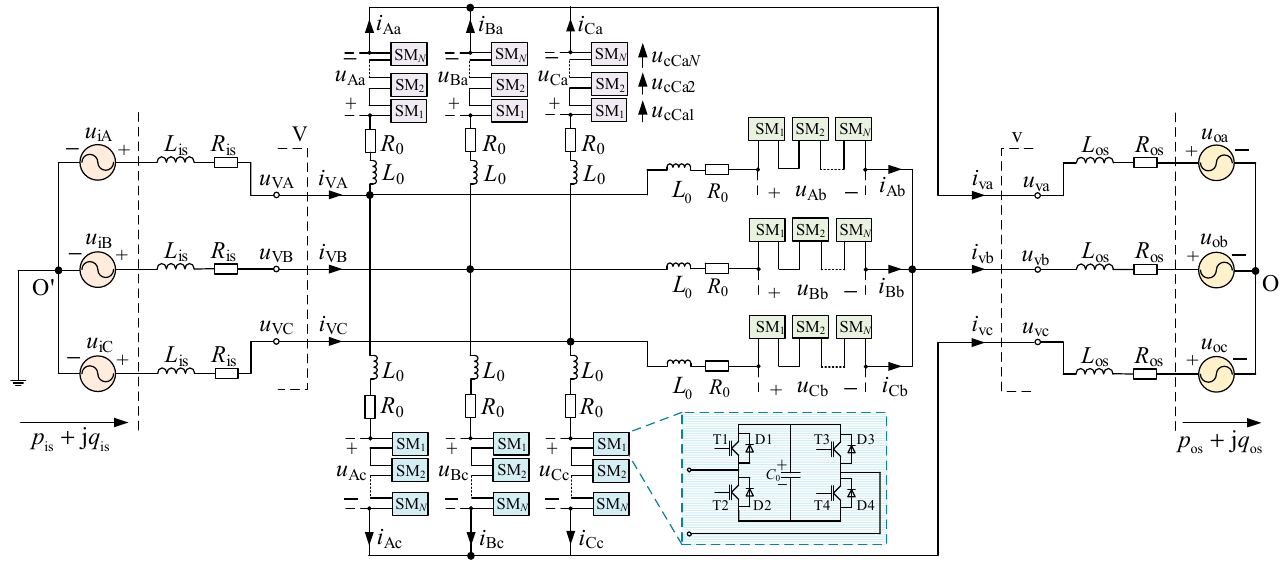
Figure 1. Main circuit structure of M3C.